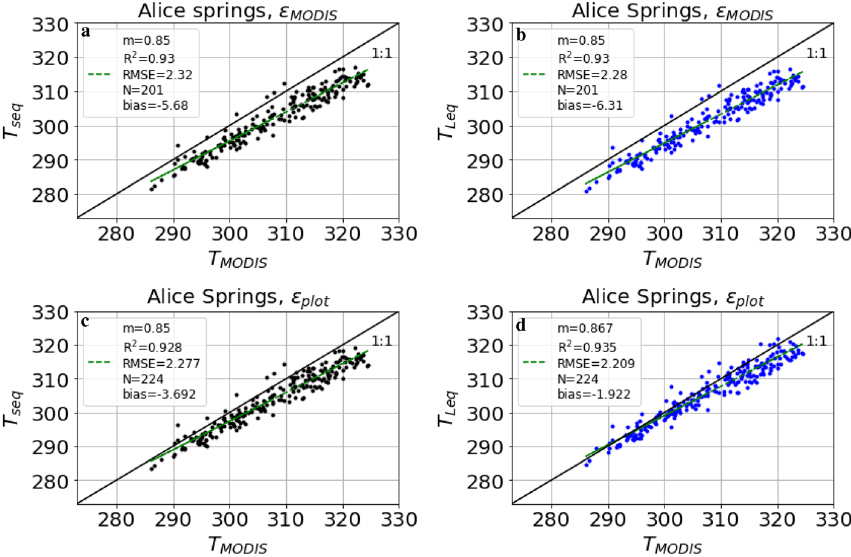
Figure 3. Landscape-scale LST ( T MODIS derived from MOD11A1) vs. plot-scale LST at Alice Springs for 2016–2018. ( a ) T seq based on short equation (Eq. 10) and satellite-derived (MODIS) broadband emissivity; ( b ) Same as ( a ), but T leq based on long equation (Eq. 6); ( c ) T seq based on short equation (Eq. 10) and monthly plot-scale emissivity; ( d ) Same as ( c ), but T leq based on long equation (Eq. 6). Bias is mean T seq − T MODIS , N is the number of daily overpasses of MODIS between 2016 and 2018, c is the intercept, m the slope, RMSE is the 2 root mean square error and R is the coefficient of determination. At each site, LST was estimated using both the short equation ( T seq , Eq. 10) and the long equation ( T leq , Eq. 6). In a first step, we used satellite-derived landscape-scale broadband emissivity from MODIS ( ε MODIS , Eq. 12) for estimating plot-scale LST from tower- based longwave measurements, and compared these with landscape-scale LST extracted from MODIS LST dataset ( T MODIS